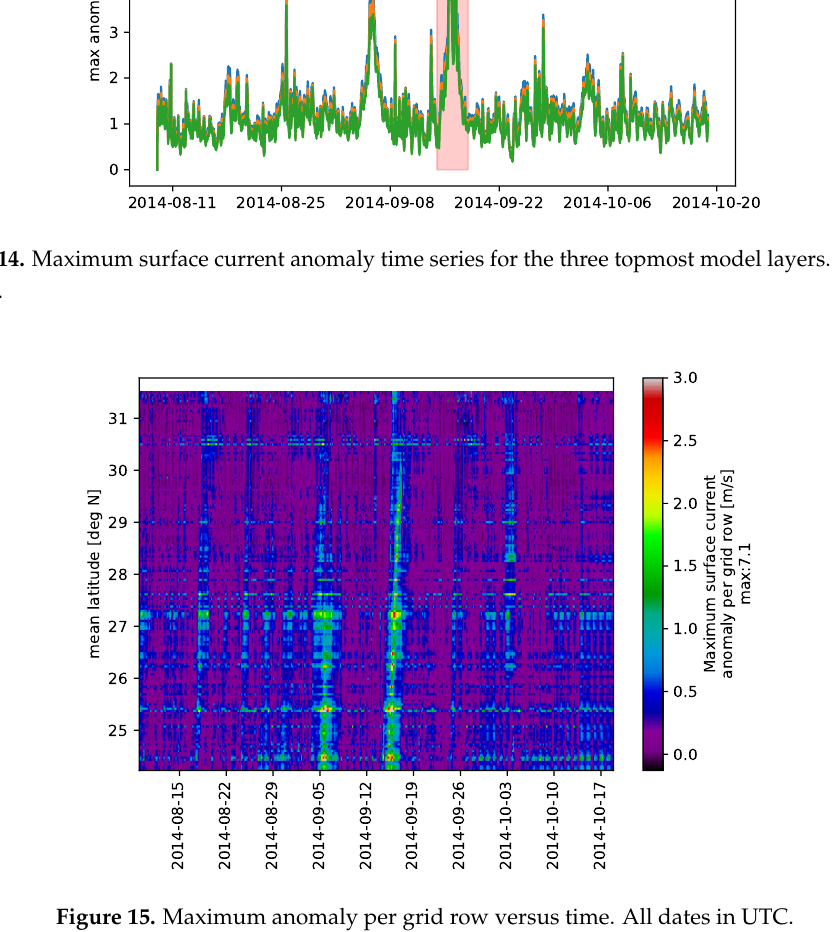
Figure 15. Maximum anomaly per grid row versus time. All dates in